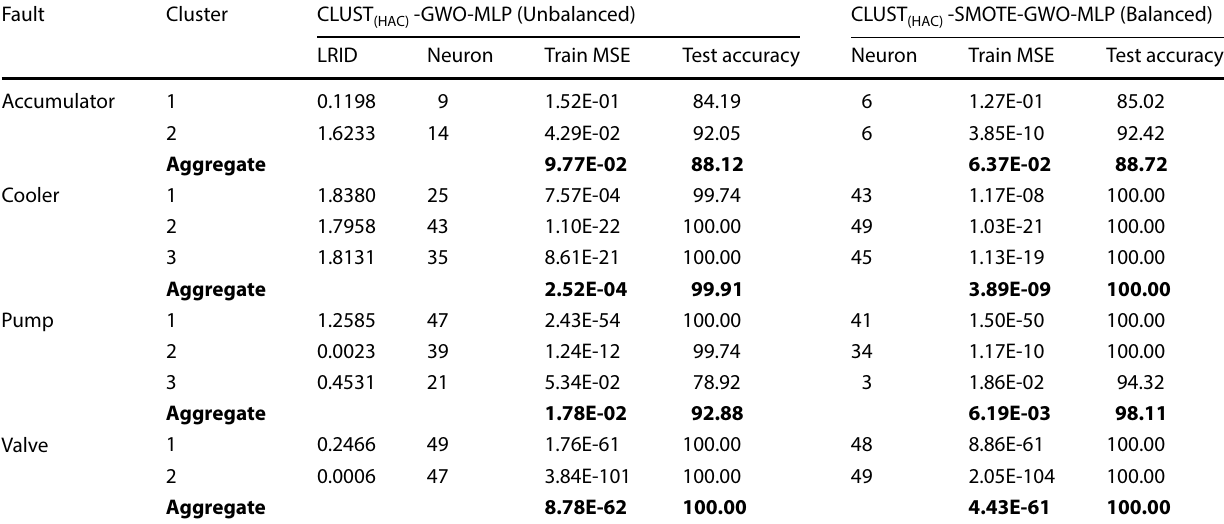
Table 9 Fault classification based on CLUST (HAC) -GWO-MLP and CLUST (HAC)